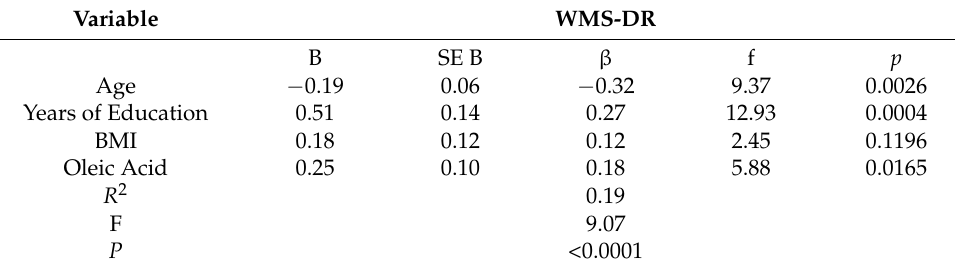
Table 7. Association between WMS-DR score and consumption of oleic